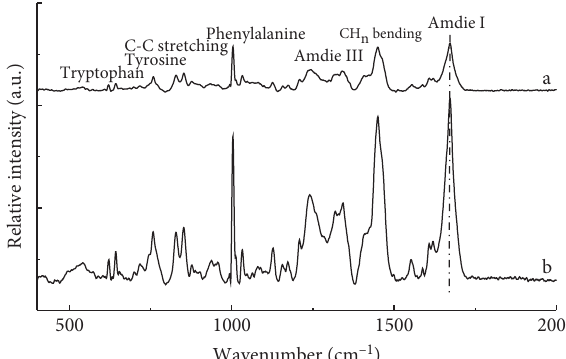
Figure 4: Raman spectrum (400–2000 cm − 1 ) of proteins in samples fermented with P. nalgiovense (a) and P. chrysogenum